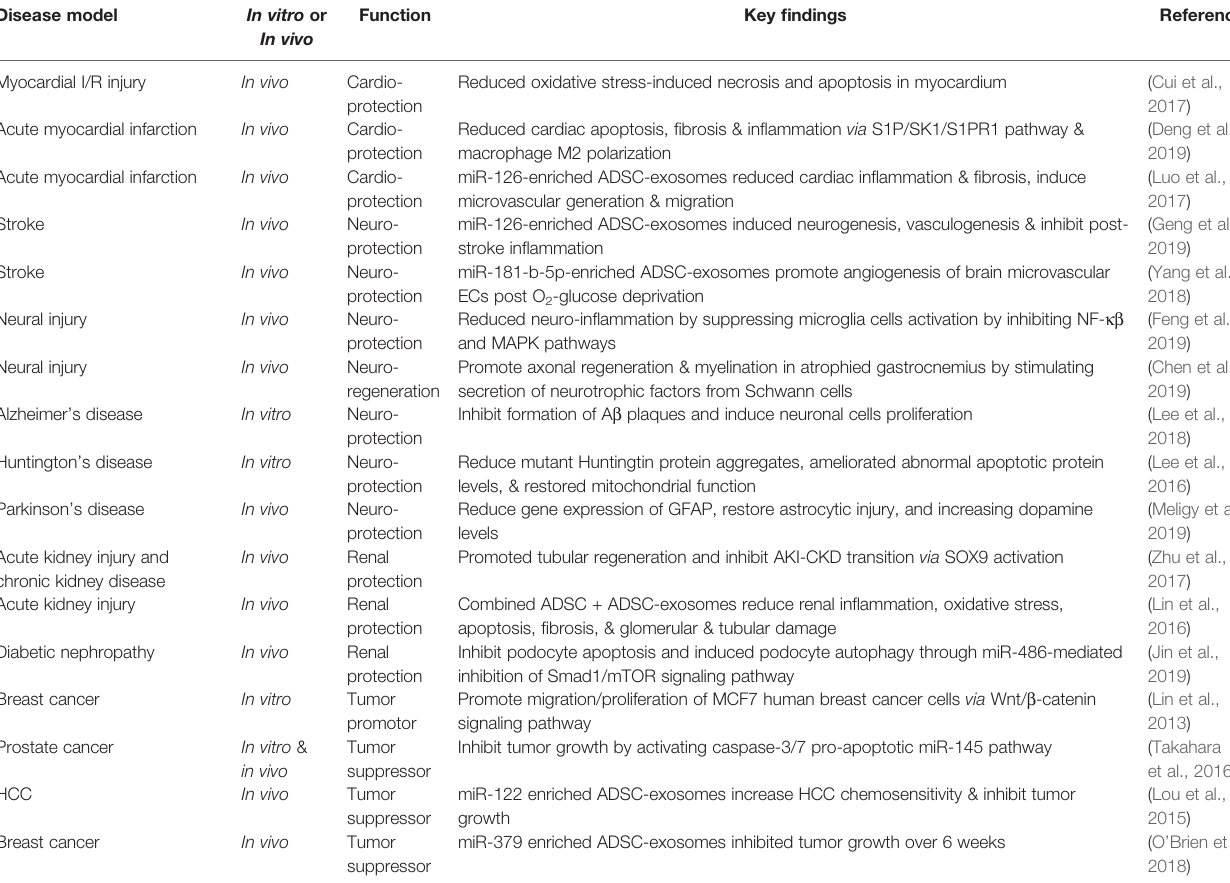
TABLE 2 | Pre-clincial studies of ADSC-EVs. Disease model In vitro or In vivo